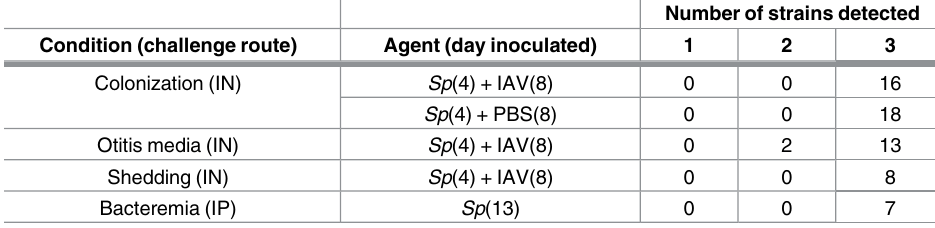
Table 1. Conditions without a tight population bottleneck.